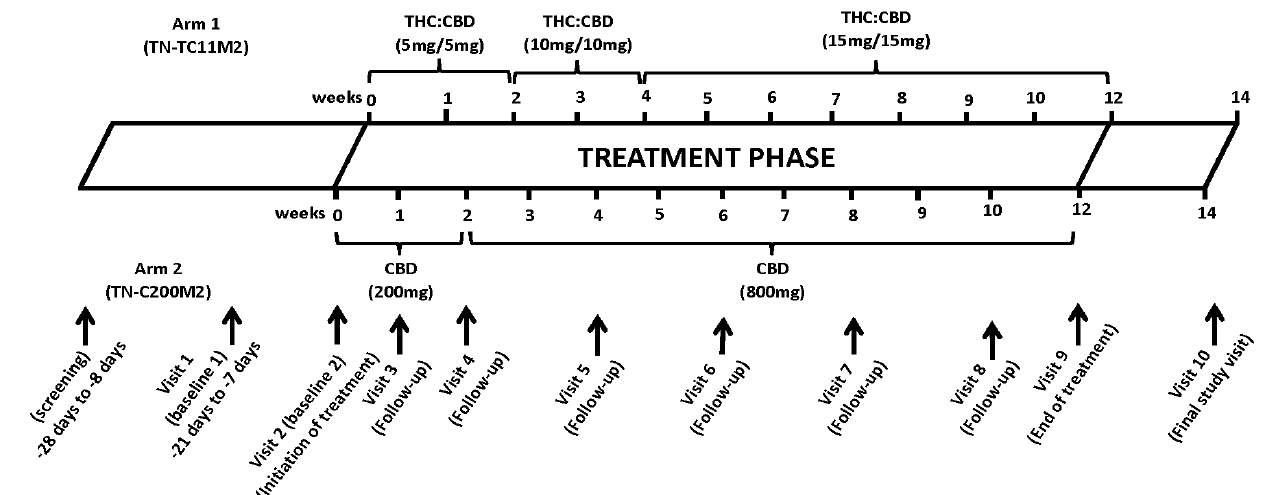
Figure 1. Schedule of visits and procedures. Screening: Up to 4 weeks prior to randomization, during the screening visit, study staff explained the study to the participants and obtained written informed consent prior to initiating any study procedures. Study staff assessed the participant’s eligibility by assessing the inclusion and exclusion criteria. Study staff collected the medical history and concomitant medications of the study participants and they underwent a complete physical exam. Blood was collected for hematology, blood chemistry, HIV RNA load and CD4 and CD8 T cells counts. A urine pregnancy test was performed for female participants. Cannabis Use Disorder Identification Test-Revised (CUDIT-R), Drug Use Disorder Identification Test (DUDIT) and Alcohol Use Disorder Identification Test (AUDIT) questionnaires were administrated to the participants and they underwent testing for Hepatitis B and C and syphilis infections. They also underwent urine screen for cannabinoids use. Baseline 1: Up to 3 weeks before the randomization, study staff confirmed eligibility of the candidate and reviewed their medical history. Participants then underwent a second cannabinoids screening test, if his/her initial screen was positive, and answered the CUDIT-R questionnaire in order to identify any problematic cannabis use. The participants underwent a targeted physical exam and blood and semen (from male) were collected to quantify the HIV reservoir size in circulating PBMC from blood and in the semen. Nasal swab and stool specimens were collected from study participants. Antiretroviral Therapy (ART) compliance, alcohol intake and concomitant medication were reviewed by the study staff. Baseline 2 (week 0: Initiation of treatment): Participants confirmed their willingness to participate in the study and eligibility was confirmed, before participants were randomized to either arm 1 or arm 2. Blood was collected from participants. Participants underwent a targeted physical exam. Participants also completed the World Health Organization Quality of Life—HIV Brief Scale (WHOQOLHIV-BREF), Euro-Qol-5Dimension (EQ-5D) questionnaire, and Profile of MoodStates (POMS) questionnaires before receiving a one week supply of the study medication. Follow-up visits (visit 3–8; week 1 to 10): During the follow-up visits, participants underwent a physical examination, and blood was collected to assess the biological study measures. Study drug and ART compliance was assessed. Adverse effects (AEs) were recorded. Pregnancy test was performed on urine of female participants. The participants completed the WHOQOLHIV-BREF, EQ-5D, and POMS questionnaires (Visit 6) and received the study medication until their next visit. End of the treatment (Visit 9; week 12): At Visit 9, participants underwent a physical examination, and blood was collected to assess the biological study measures. Nasal swab and stool specimens were collected from all study participants and semen was collected from male participants. AEs were recorded. A pregnancy test was performed on urine of female participants. Participants then completed the WHOQOLHIV-BREF, EQ-5D, and POMS questionnaires. Final study visit (Visit 10; week 14): At the final visit, participants underwent a physical examination, and blood was collected to assess the biological study measures. AEs were recorded and ART compliance was assessed. A pregnancy test was performed on urine of female